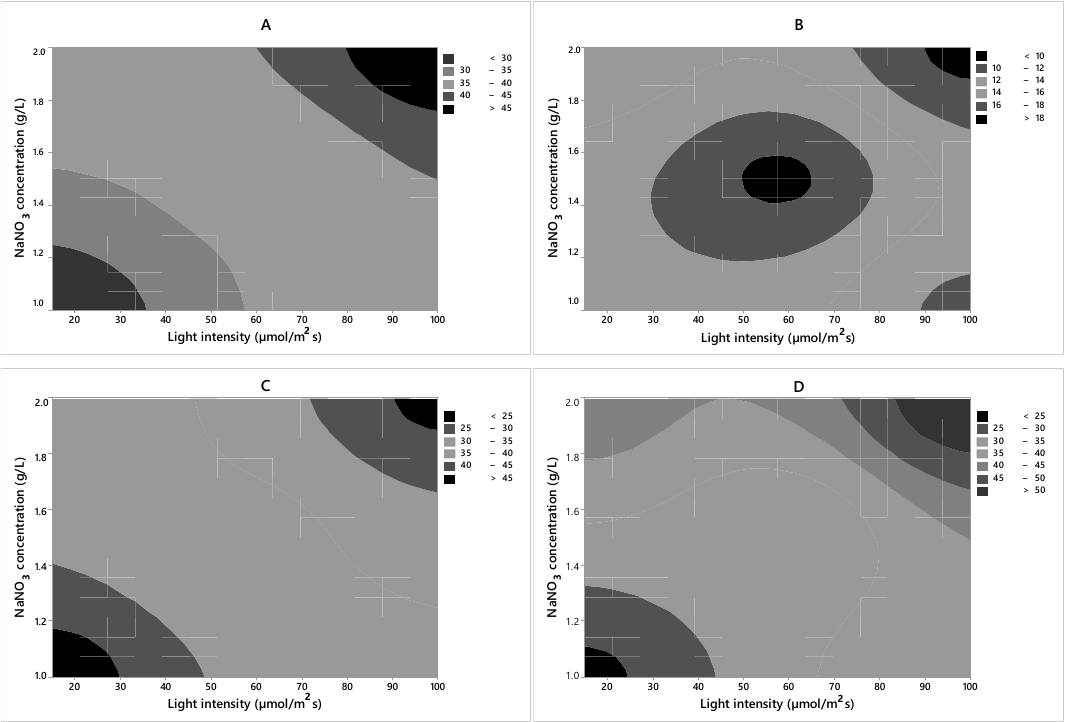
Figure 3. Level curves for the biomass productivity (mg / L / day) as a function of the independent variables for each strain. ( A ) Synechocystis sp. CACIAM05; ( B ) Microcystis aeruginosa CACIAM08; ( C ) Pantanalinema rosaneae CACIAM18; ( D ) Limnothrix sp. CACIAM25.